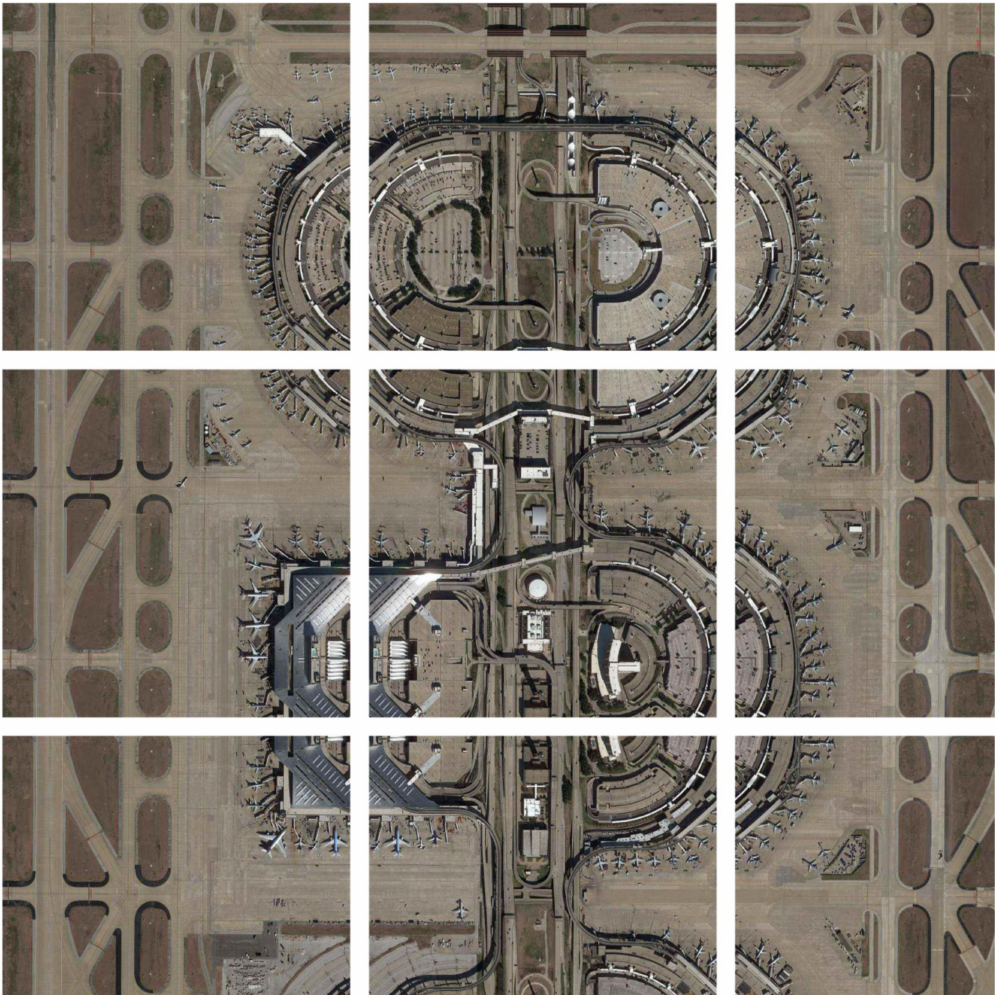
Figure 7. The MultiBlock layer. The input image is divided into nine overlapped blocks after the MultiBlock layer is